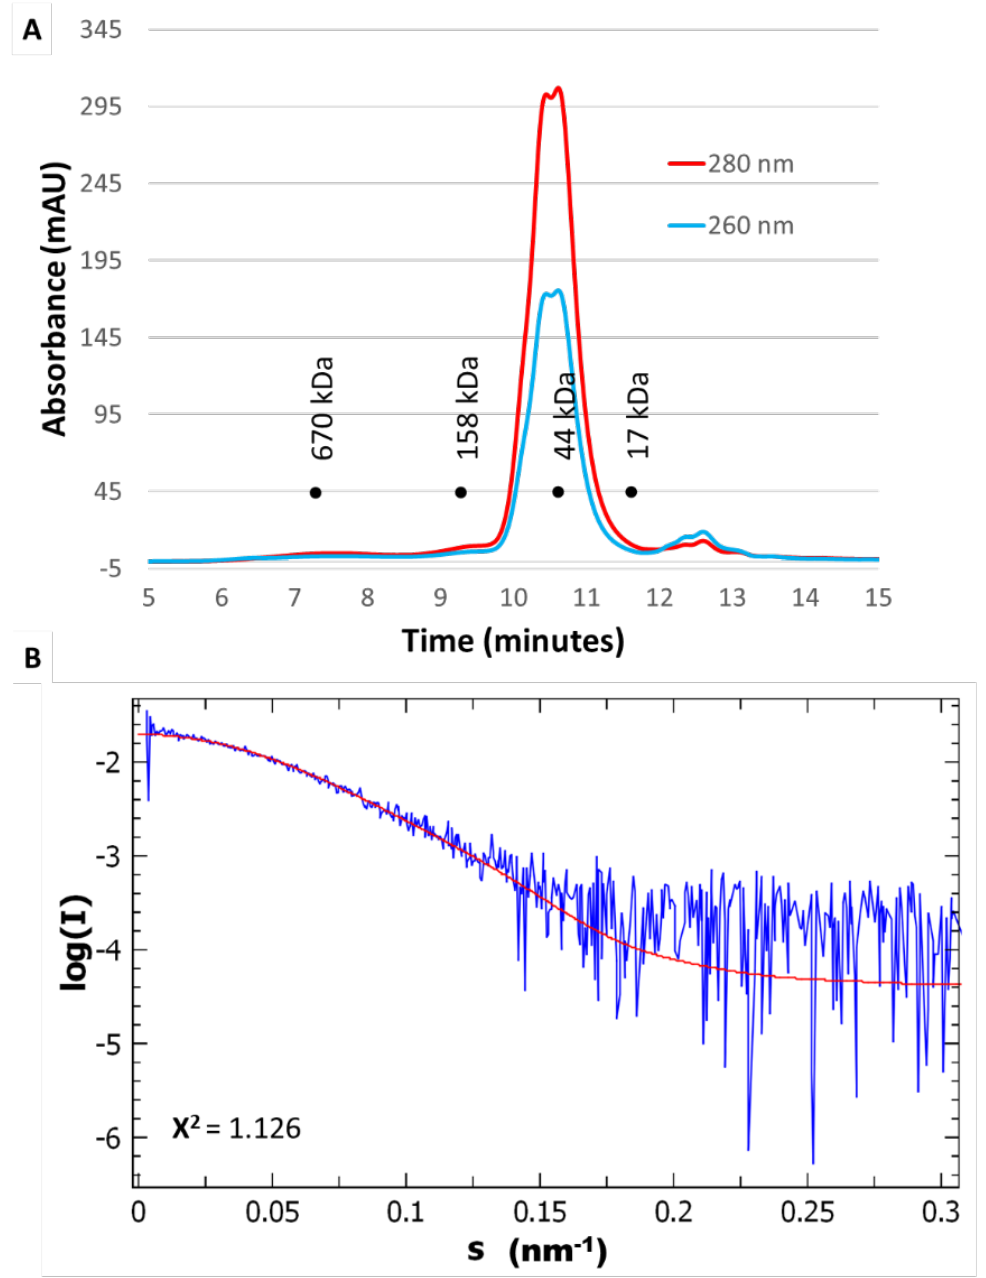
Figure 2. Size-exclusion chromatography coupled to small angle X-rays scattering (SEC-SAXS) analysis of CrRPI1. ( A ) High performance liquid chromatography (HPLC) chromatogram of CrRPI1 with absorption at 280 nm in red and at 260 nm in blue. ( B ) SAXS scattering curve log(I) = f(s) in blue was fitted to the crystallographic dimeric model of CrRPI1 in red.